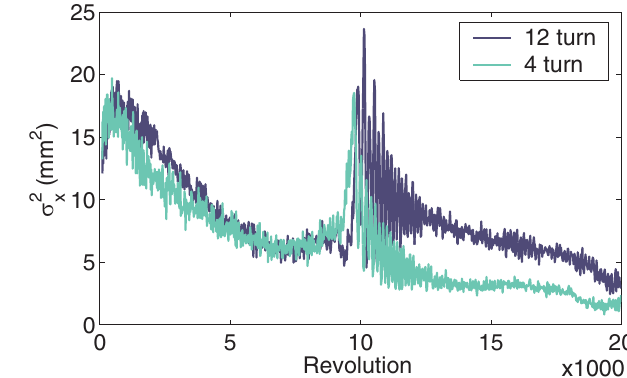
FIG. 13. (Color) (cid:2) 2 for 4-turn and 12-turn injection. The beam x widths below and above transition energy shows adiabatic damp- ing, while the beam width is enhanced at the transition-energy region due to the increase of the momentum width.